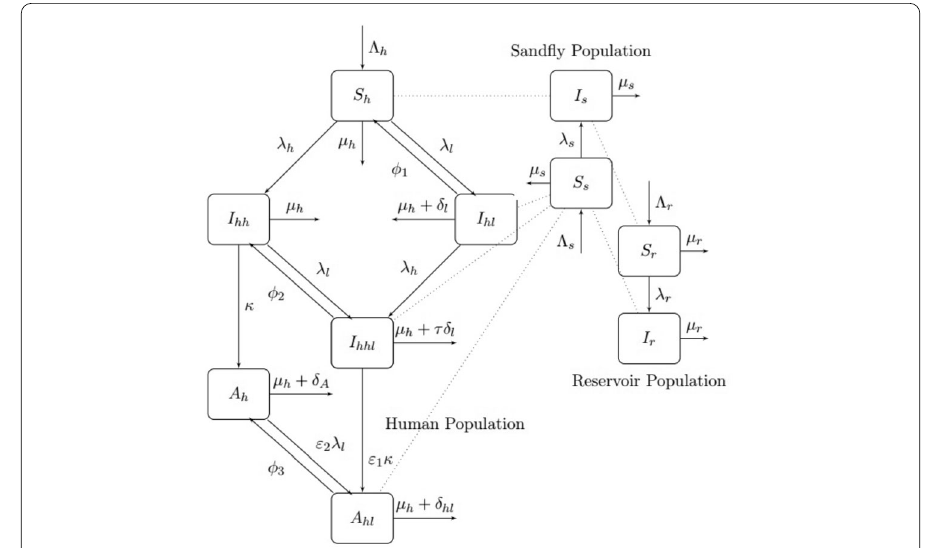
Figure 1 Compartmental diagram of HIV–VL on co-infectious